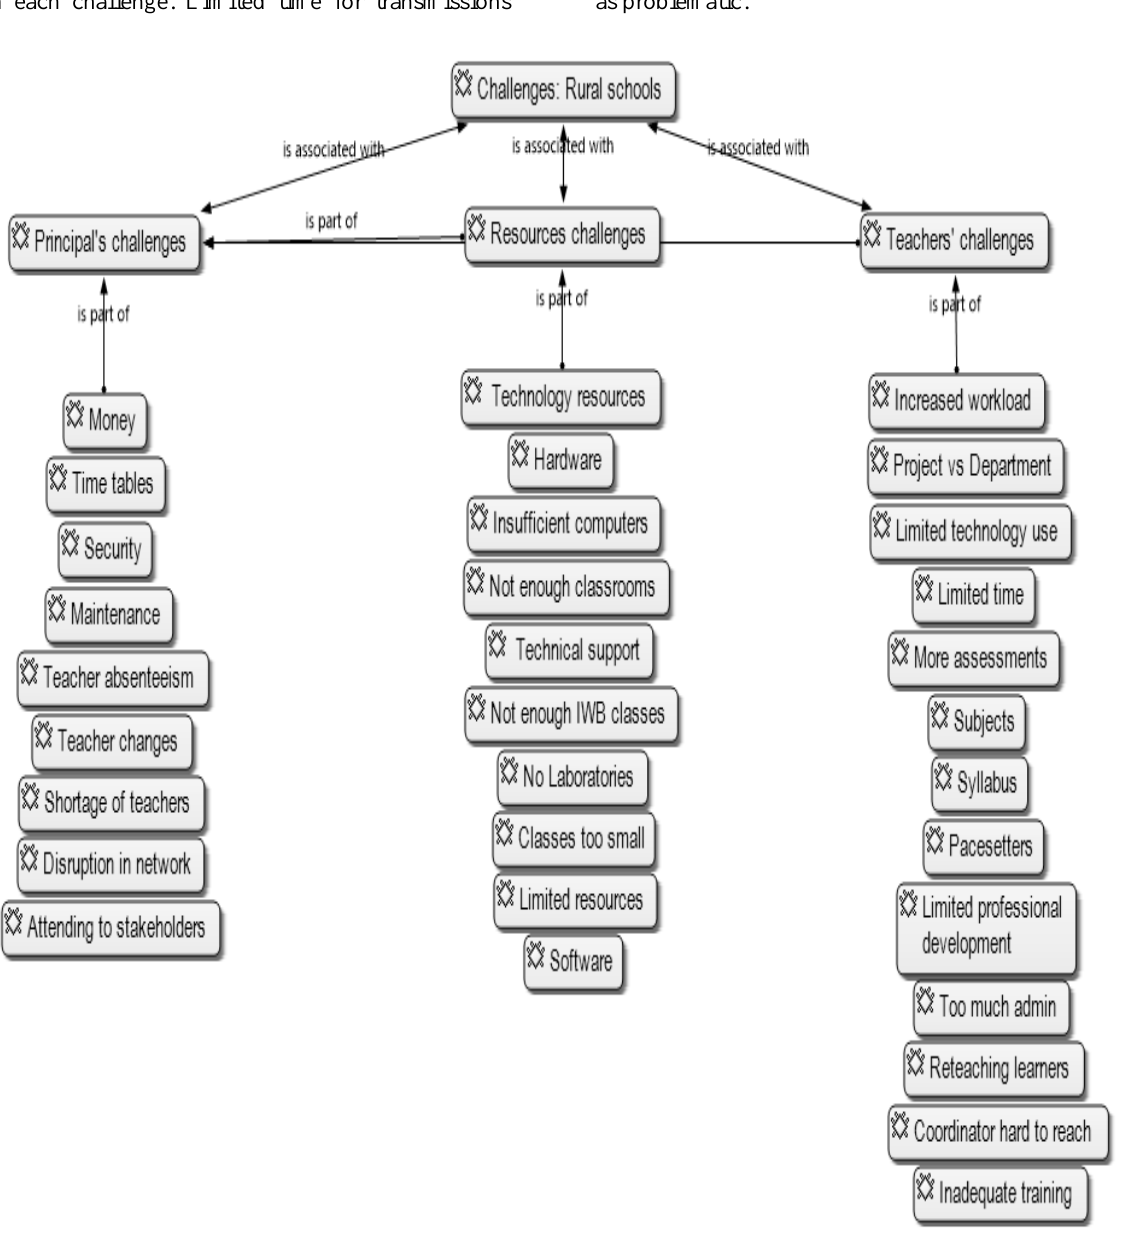
Figure 2 The management challenges in the rural